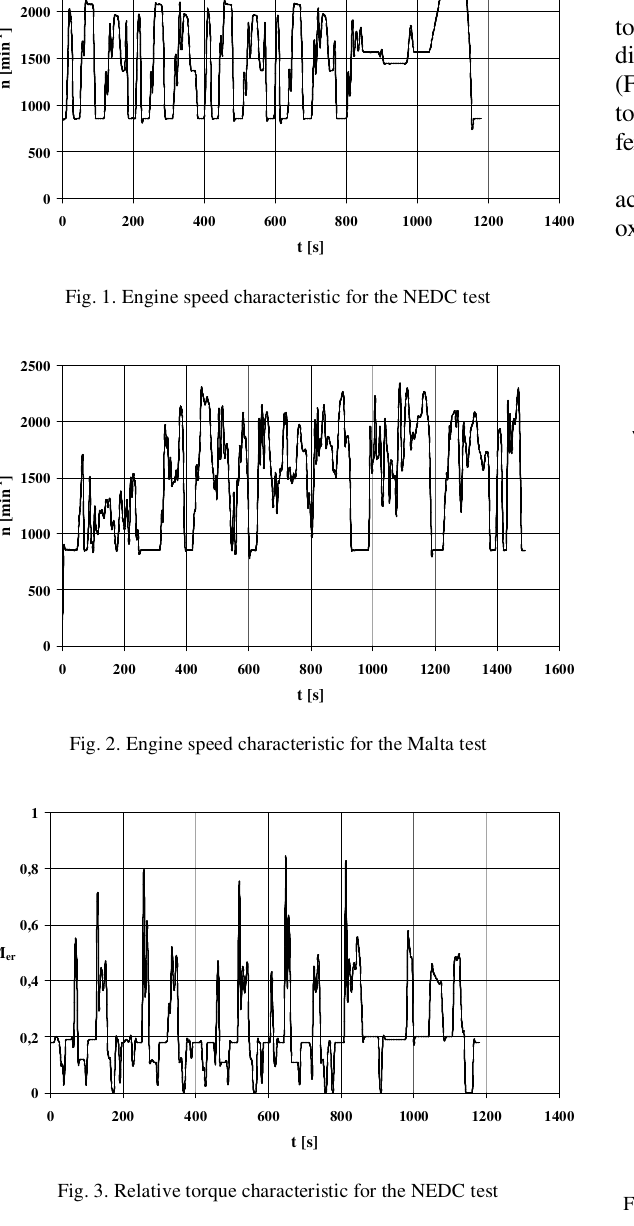
Fig. 6. Rotational speed coefficient of variation in NEDC and Malta